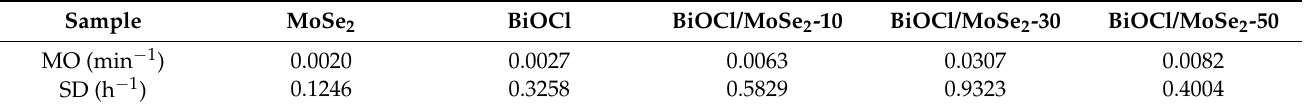
Table 1. The kinetic constants of photocatalytic degradation of MO and SD over the different samples. Sample MoSe 2 BiOCl BiOCl/MoSe 2 -10 BiOCl/MoSe 2 -30 BiOCl/MoSe 2 -50 MO (min − 1 ) 0.0020 0.0027 0.0063 0.0307 0.0082 SD (h − 1 ) 0.1246 0.3258 0.5829 0.9323